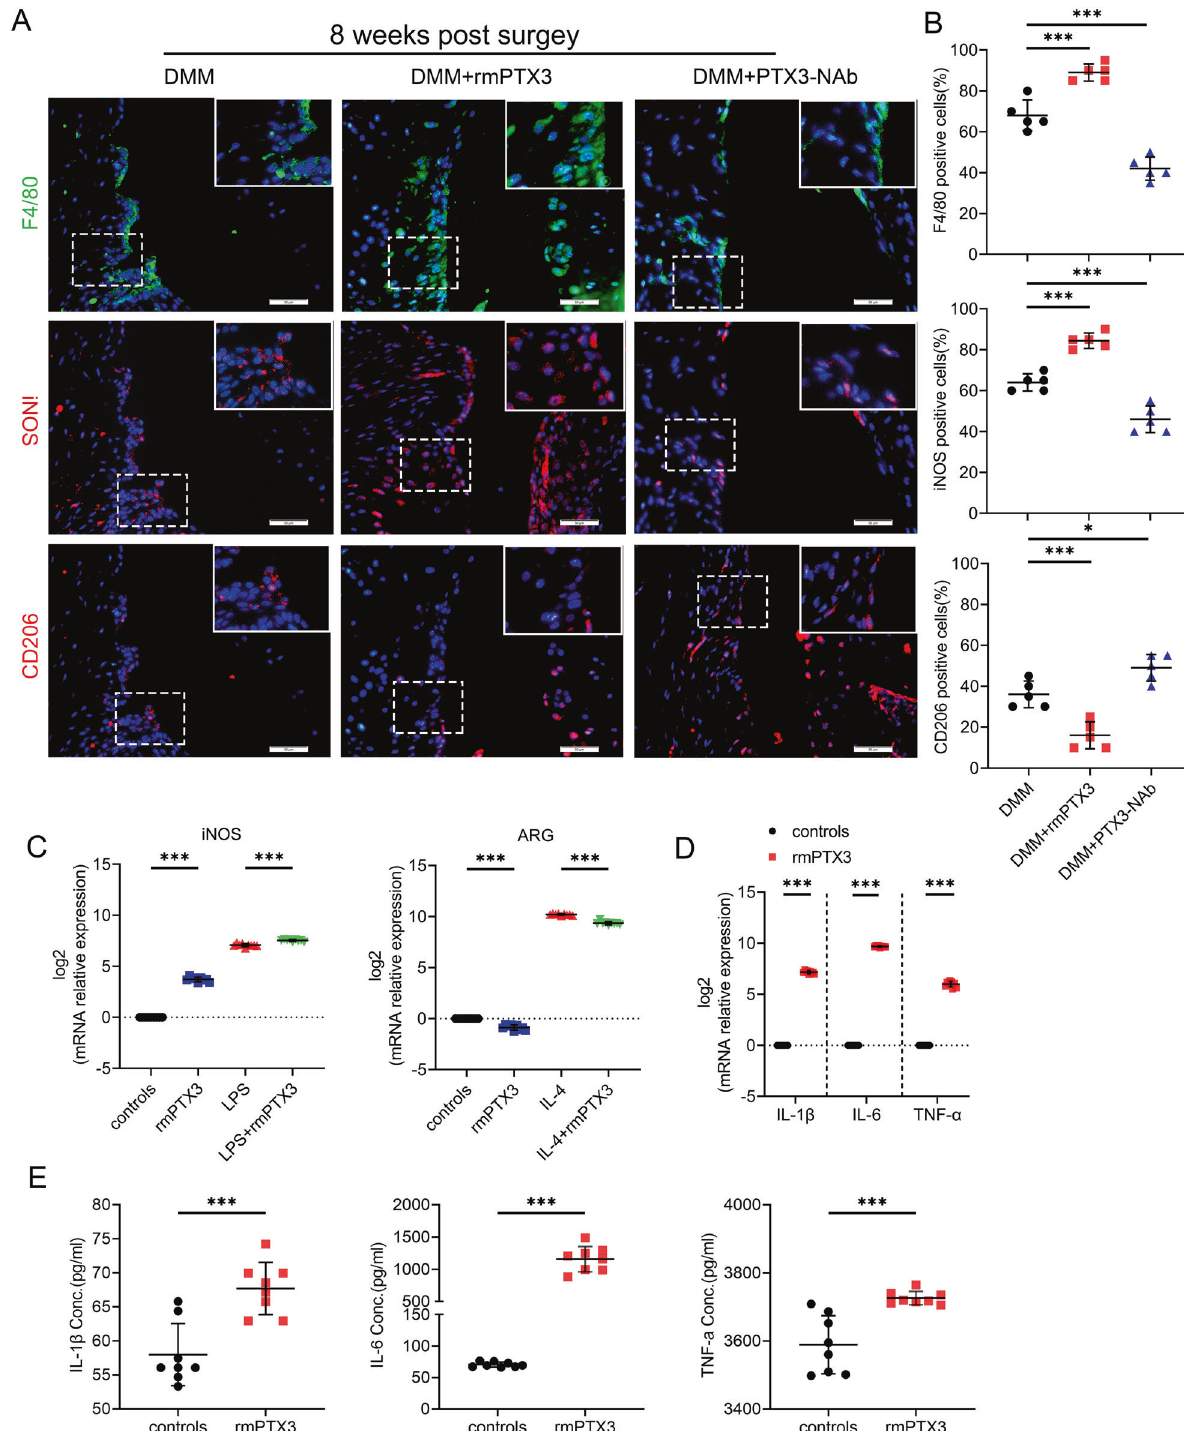
Fig. 3 PTX3 enhances M1 polarization and promotes production of in fl ammatory cytokines in OA synovium. A , B IF staining and quanti fi cation of F4/80 (upper), iNOS (middle), and CD206 (lower) in synovial tissues of DMM mice treated with vehicle, rmPTX3 or PTX3-NAb for 8 weeks, n = 5 per group. Scale bar: 50 µm. C Relative mRNA expression level of iNOS and ARG in LPS-, IL-4- or rmPTX3-treated RAW264.7 cells, n = 9 per group. D Relative mRNA expression level of IL-1 β , IL-6, and TNF- α in rmPTX3-treated RAW264.7 cells, n = 9 per group. E ELISA of IL-1 β , IL-6, and TNF- α in the supernatants of RAW264.7 treated with rmPTX3, n = 8 per group. * P < 0.05, ** P < 0.01, *** P < 0.001, ns not signi fi cant. Data are shown as means ± SD. Statistical analyses were conducted by one-way analysis of variance followed by Dunnett ’ s multiple comparison test ( B ), two-way analysis of variance followed by Sidak ’ s multiple comparison test ( C ) or unpaired t -test ( D and E ). Boxed area is enlarged in the top right corner.